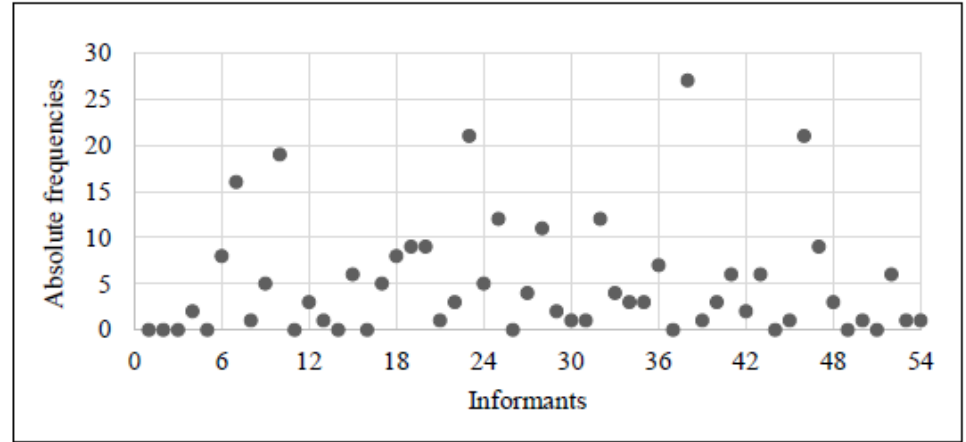
Figure 1. Dispersion of the cases of vamos in the total number of informants in the sample 4 . The first informants (young, university-educated) did not use vamos on any occasion, so we initially per- ceived that this form of speech was typical of other age groups or speakers with a non-university education. We also found a high use in certain informants, such as speakers 7 and 10 (middle-aged with university education), speaker 23 (young with secondary education), and subjects 38 and 46.